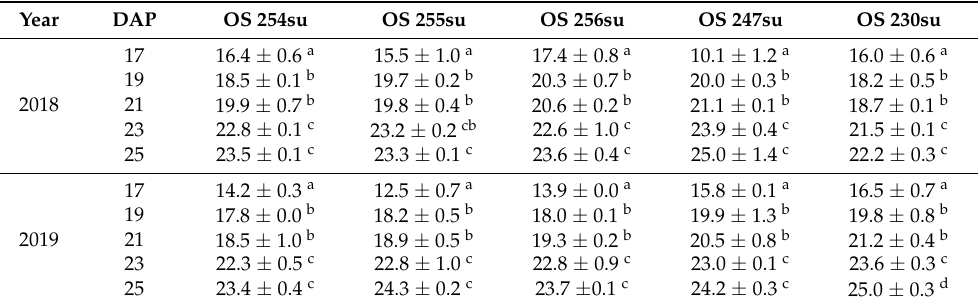
Table 4. Kernel phytoglycogen content (%) in five su1 sweet corn hybrids at five harvest dates (17–25 DAP) in two growing seasons (Osijek, 2018 and 2019). The different lowercases show signifi- cant differences among the harvest dates within hybrids ( p <